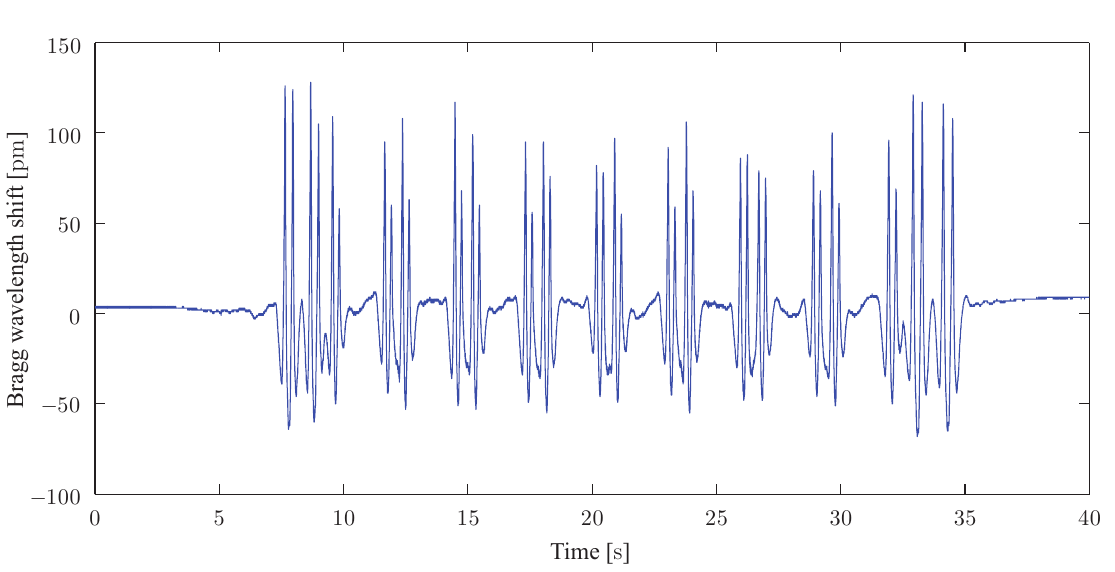
Figure 13. Trace (Bragg wavelength shift with time) of an FBG glued on the foot of a 50E2 rail and subject to a train circulating at 40 km / h